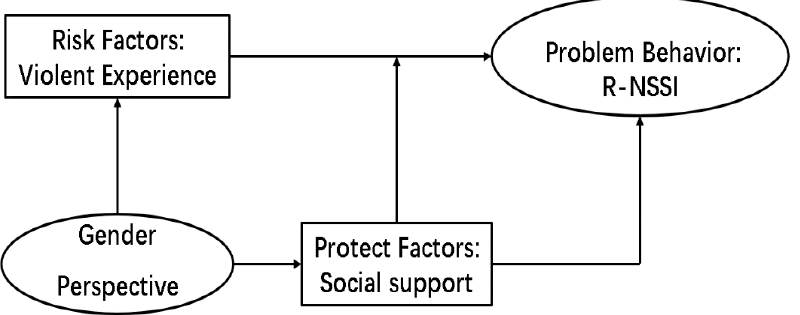
Figure 1. Problem behavior theory explanation model of repetitive nonsuicidal self-injury (R-NSSI) behavior of